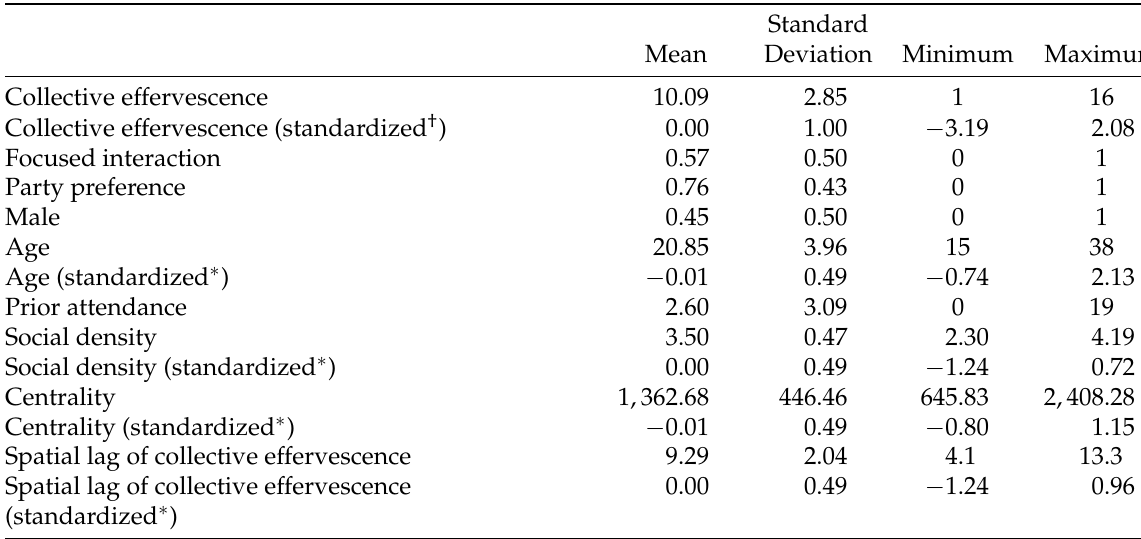
Table 1: Descriptive